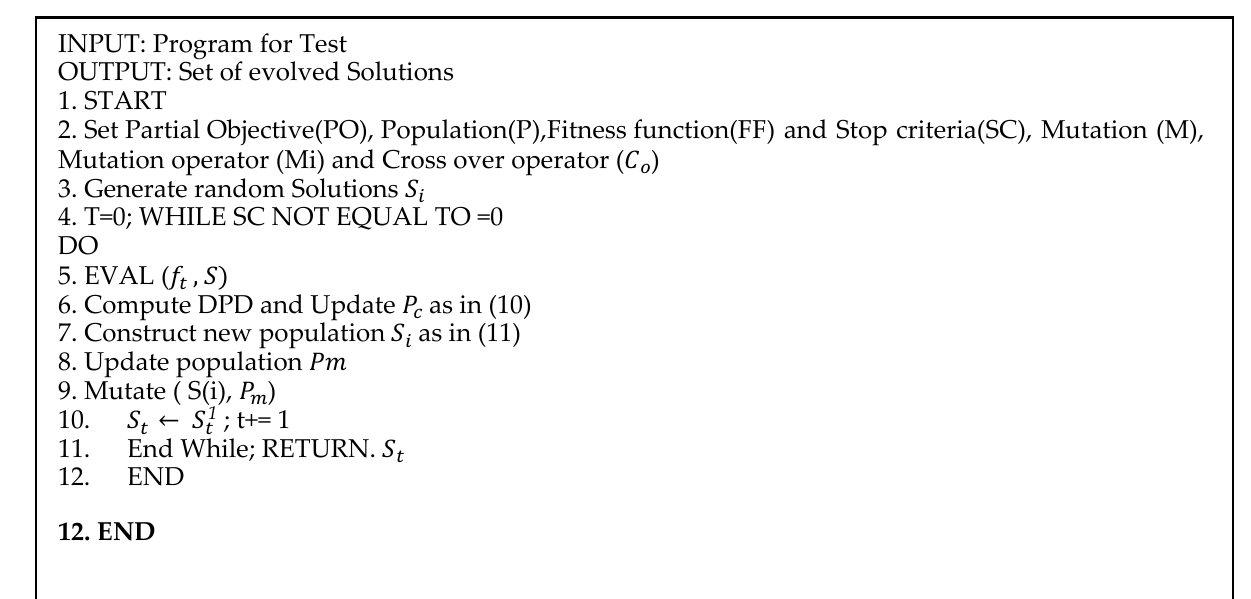
Figure 3. Algorithm for test case generation.